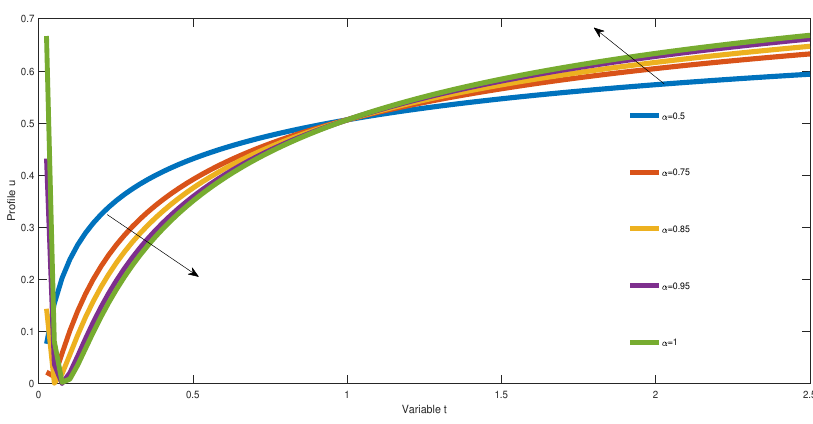
Figure 3. Profiles with different values of the fractional